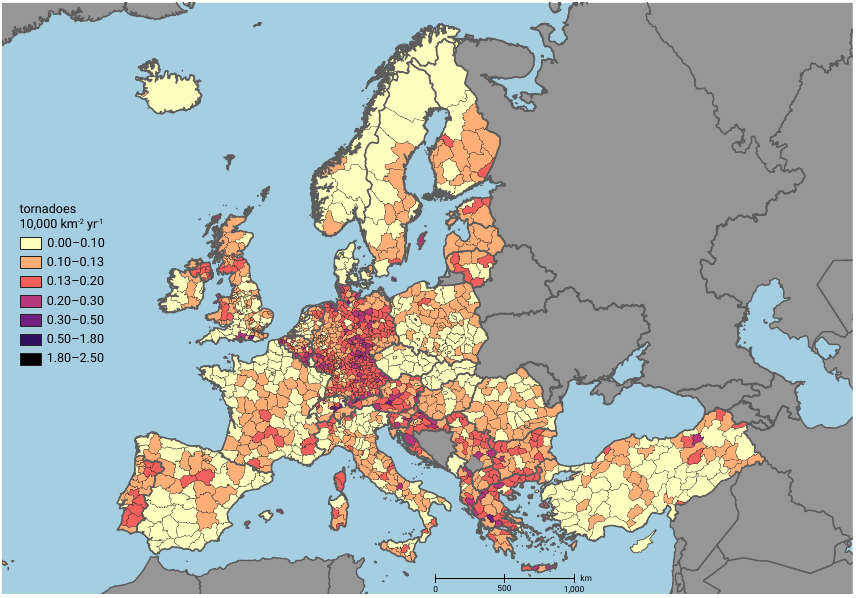
Figure 2. As in Figure 1, but for the standard deviation of tornado occurrence from posterior